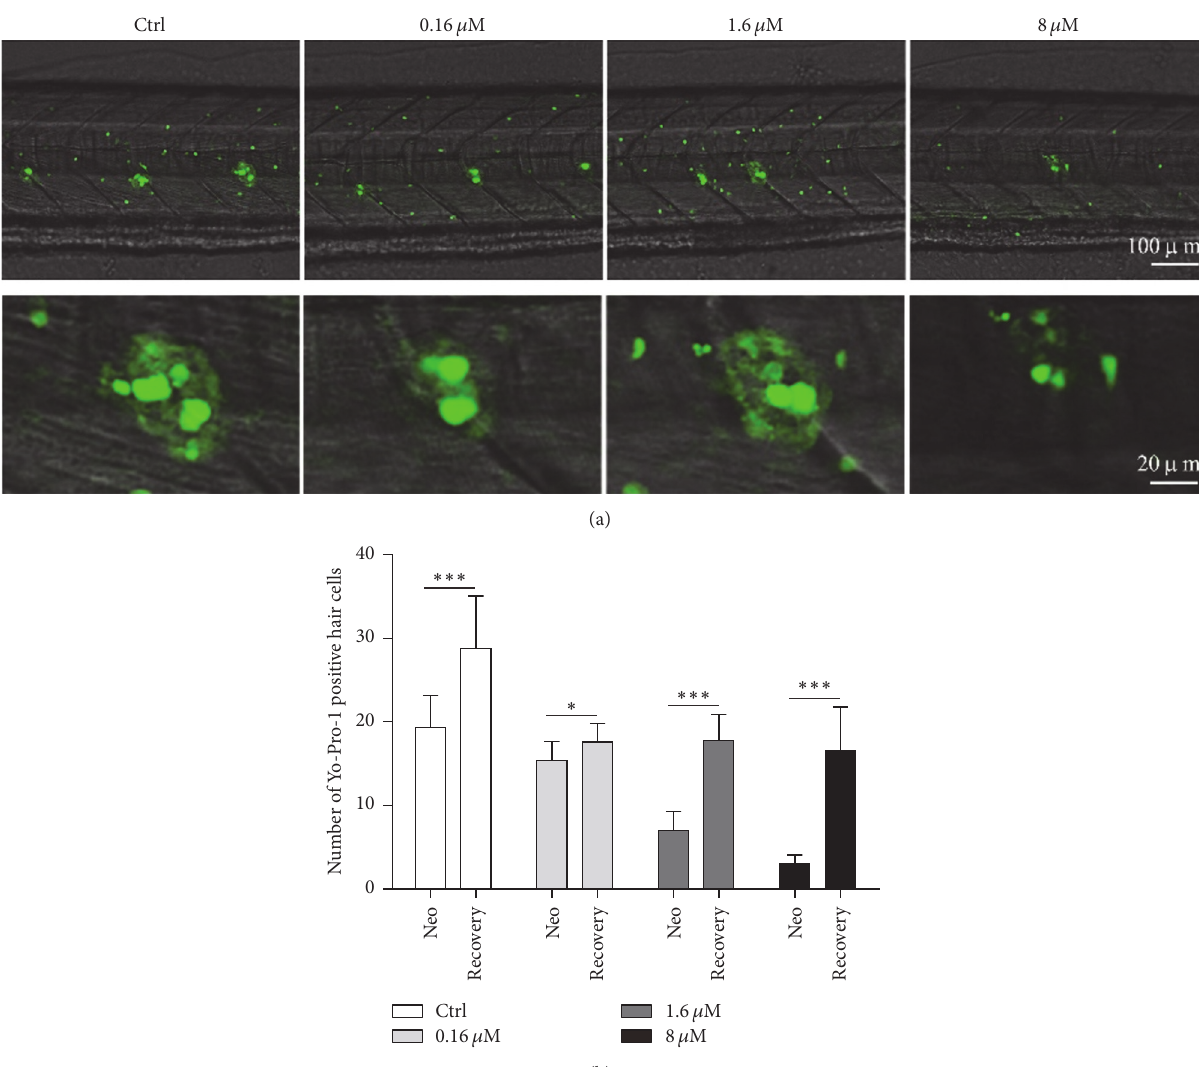
Figure 4: Neomycin-induced neuromast hair cell damage and regeneration. (a) Confocal image of lateral line neuromasts under neomycin treatment in wild-type zebrafish. (b) Average number of neuromast hair cells in each group. Each group consists of 10 7 dpf zebrafish larvae treated with respective concentration for 24 h and then allowed to recover for 72 h to assess hair cell regeneration. All neomycin-treated larvae showed decreased number of hair cells to some extent; statistical analyses were performed using Student’s t -test ( ∗ 𝑝 < 0.05 ; ∗∗∗ 𝑝 < 0.001 ). Error bars are standard